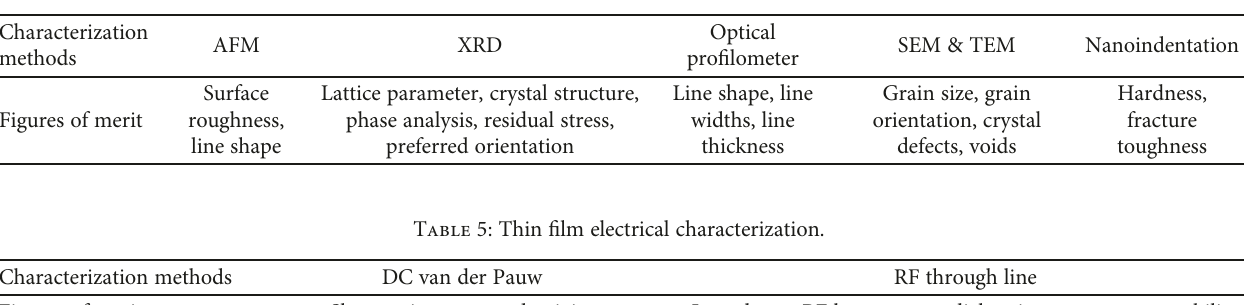
Table 4: Thin fi lm microstructure analysis.